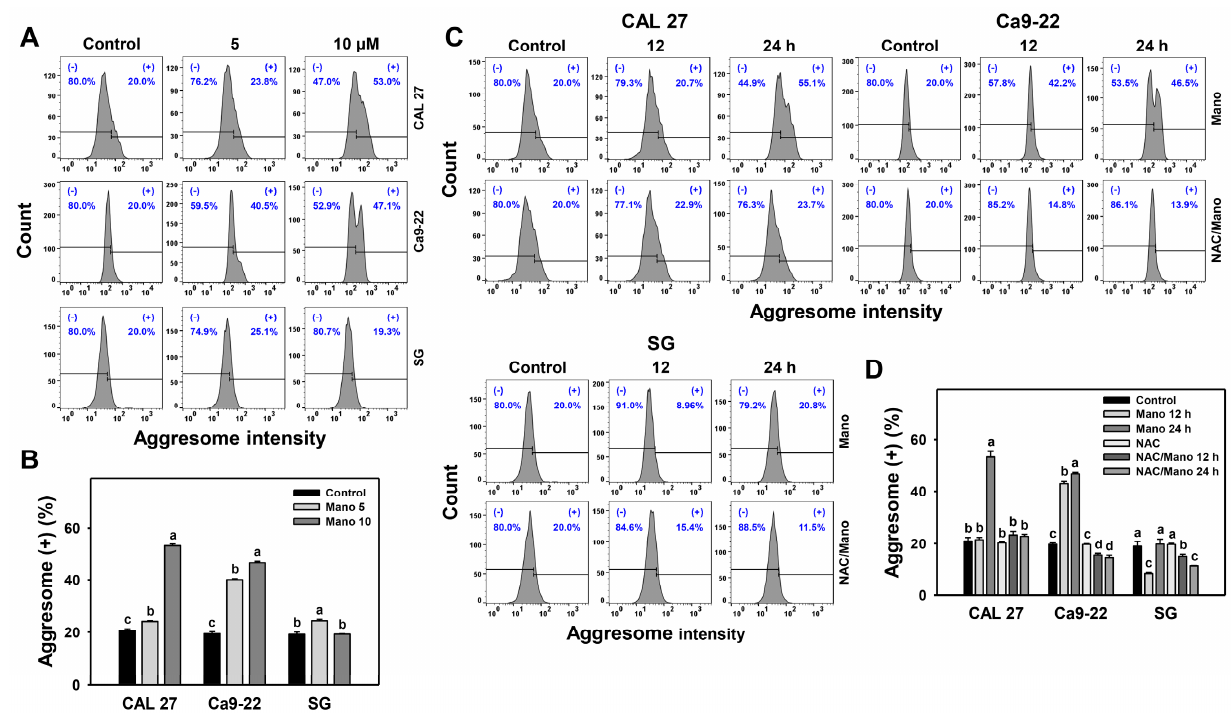
Figure 2. Manoalide causes the aggresome accumulation of oral cancer cells. ( A , B ) Aggresome analyses. Oral cancer and normal oral (SG) cells received control, 5, and 10 µ M manoalide treatments for 24 h. (+) was marked for aggresome (+) (%). ( C , D ) NAC effects on time course changes of manoalide-induced aggresome. Following NAC (10 mM for 1 h), cells received manoalide treatment (control and 10 µ M) for 12 and 24 h, i.e., NAC/Mano. Data, means ± SDs ( n = 3). Multiple comparisons were analyzed for the same cell lines. Treatments marked with different notes indicate significant differences ( p < 0.05 to 0.0001).